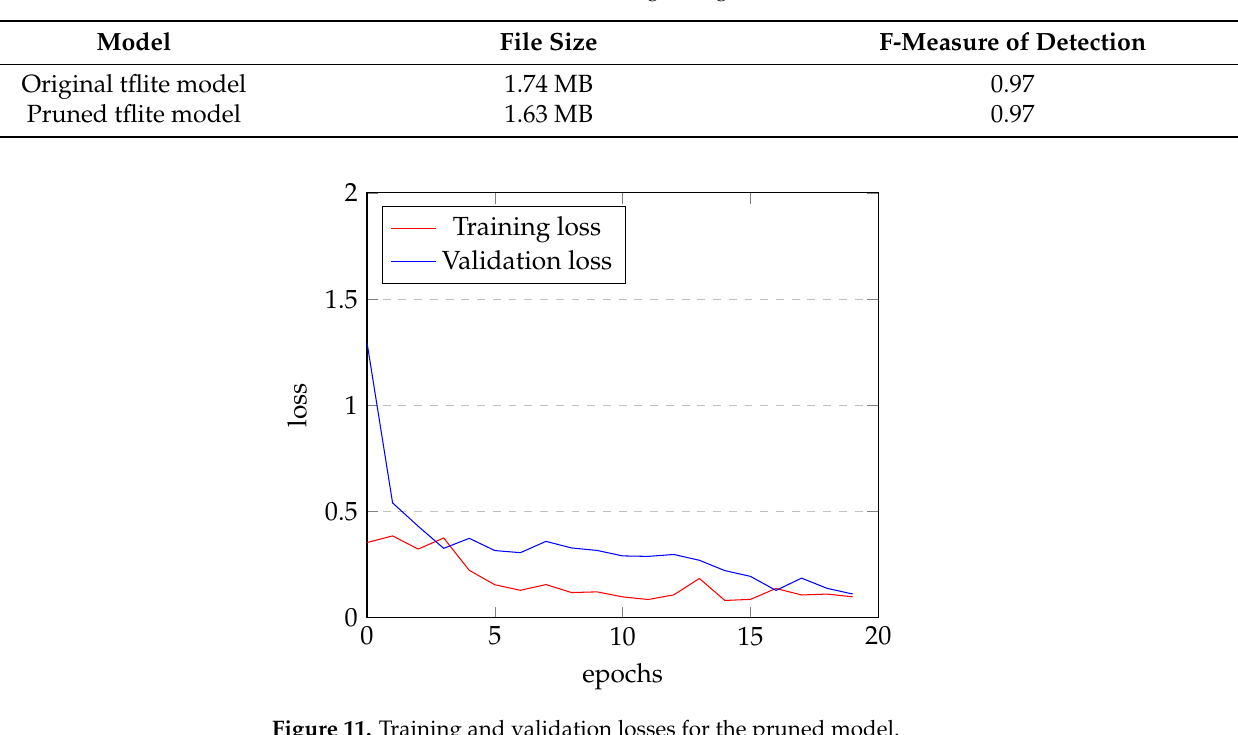
Table 9. Evaluation of the lightweight model.